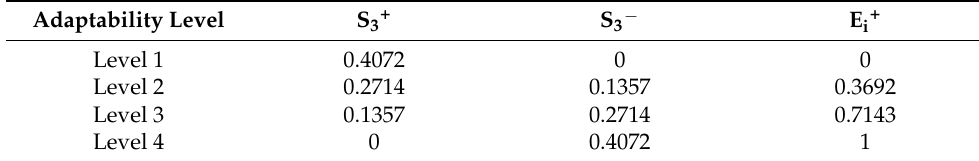
Table 13. Adaptability grade standard.